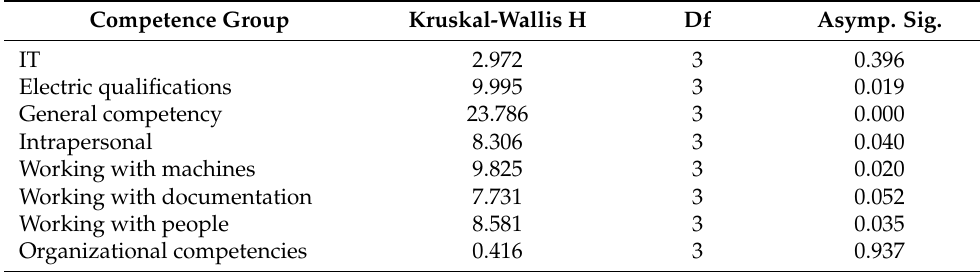
Table 12. Companies and the number of competencies.